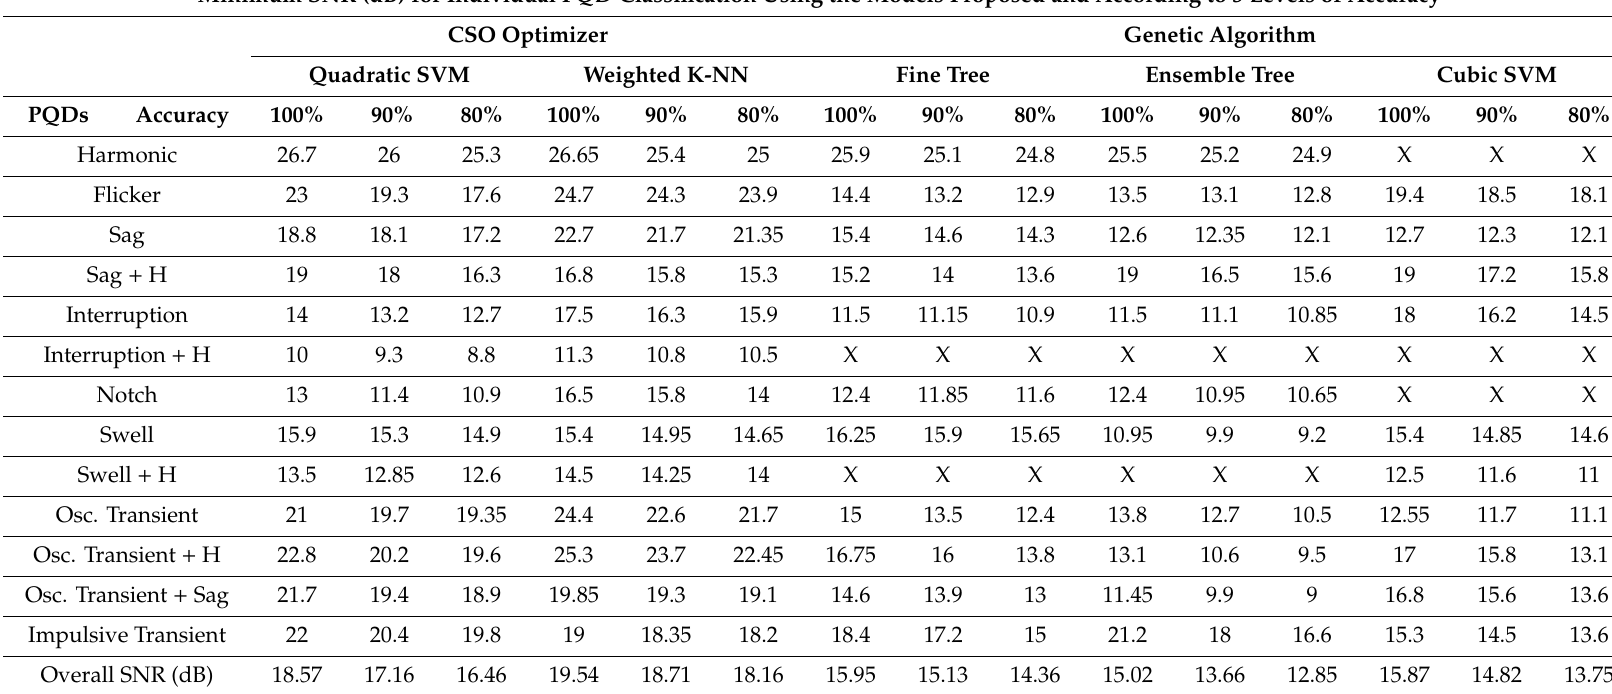
Table 4. Comparison of noise threshold (SNR minimum) for classification accuracy of the models